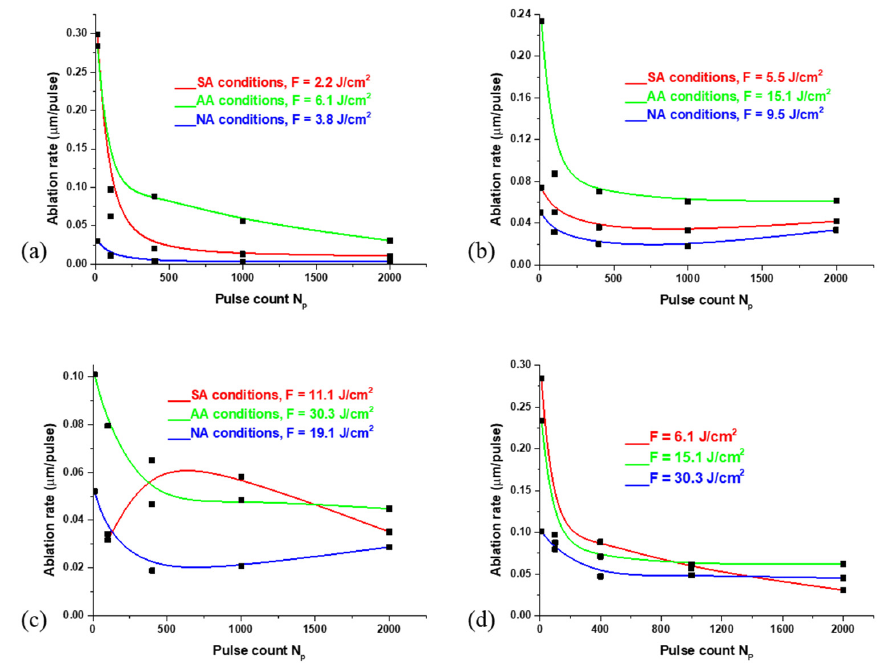
Figure 3. The dependence of ablation rate on the pulse count ranging from 10 to 2000 accumulated pulses, after the irradiation of the Nimonic 263 superalloy surface by picosecond Nd:YAG laser in different environmental conditions and with pulse energy of: ( a ) E p = 6 mJ; ( b ) E p = 15 mJ; ( c ) E p = 30 mJ. In ( d ), the dependence is given with the same environmental conditions (argon-rich atmosphere) and different laser fluences.